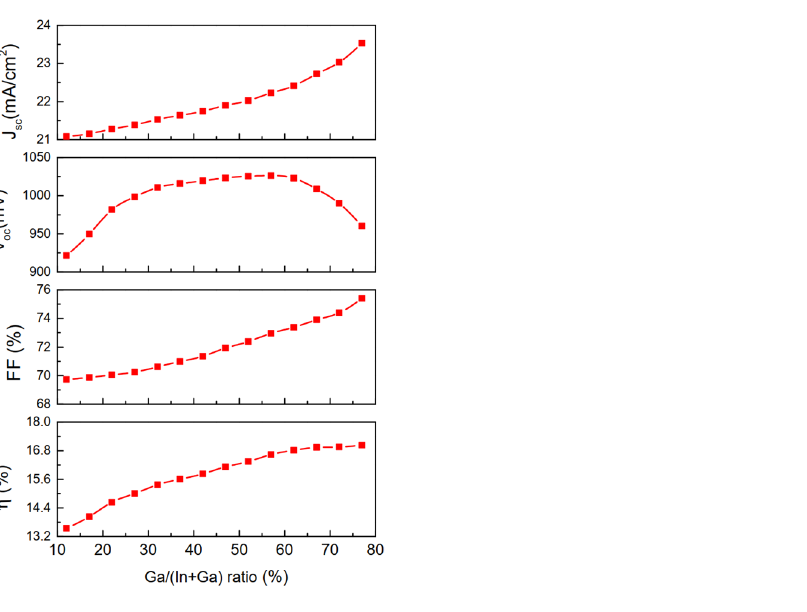
Figure 16. PV characteristics of u-CIGS cells for different sub-layer thicknesses.